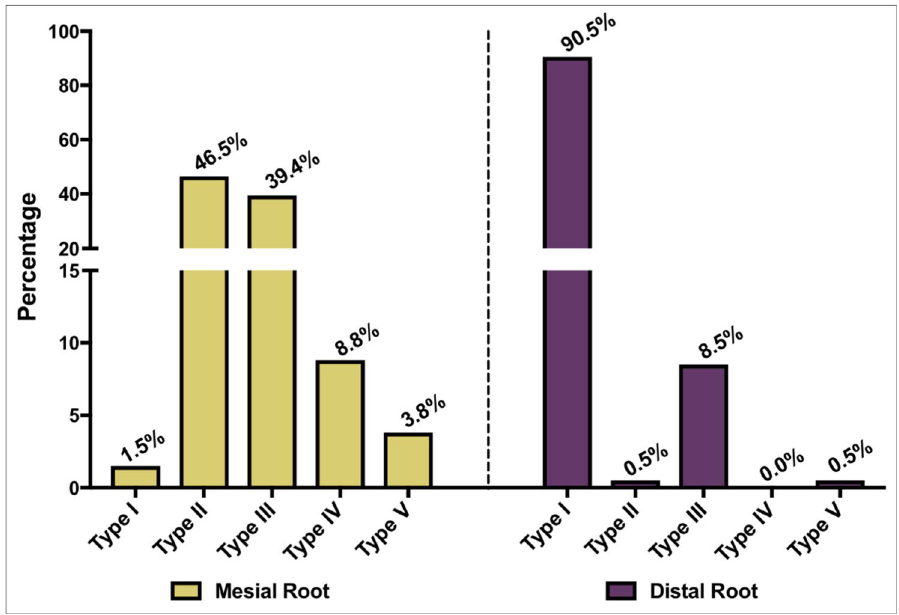
Figure 3. Bar chart indicating the percentages of different types of VC in the mesial and distal roots in the two rooted non-C-Shaped mandibular second